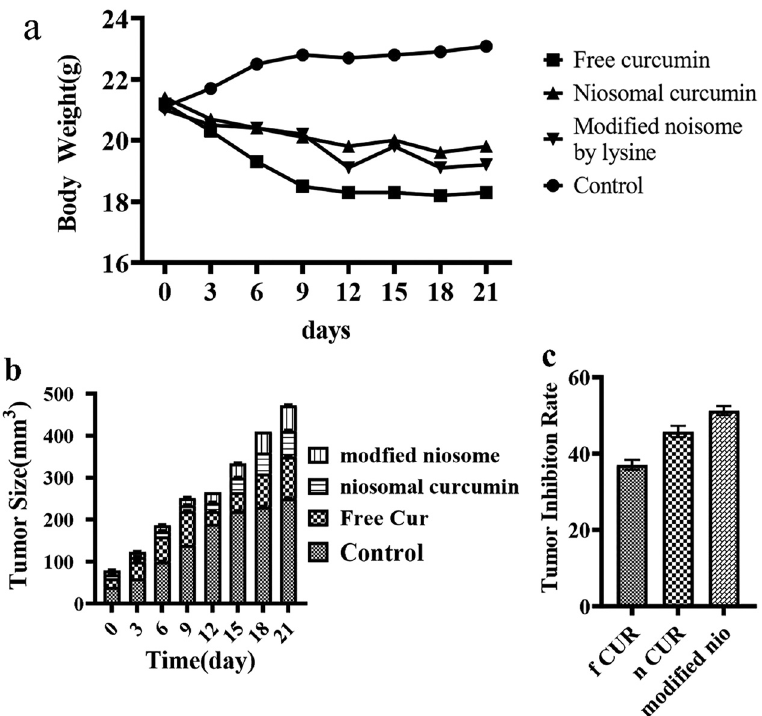
Figure 11: ( a ) In fl uence of di ff erent formulations on the mouse weight, evaluated every 3 days. ( b ) The e ff ects of the formulations on the tumor size ( mm 3 ) . ( c ) Tumor inhibition rate ( f: free; n: noisome; nio: niosome ) . Data were exhibited as the mean ± SD and p < 0.05 was considered a signi fi cant statistical di ff